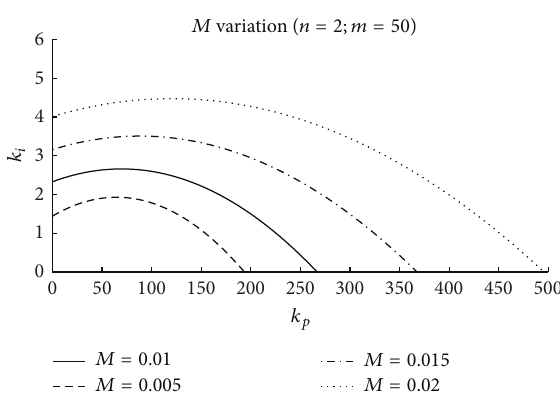
Figure 8: Stability regions: comparison of normal and flood operation.